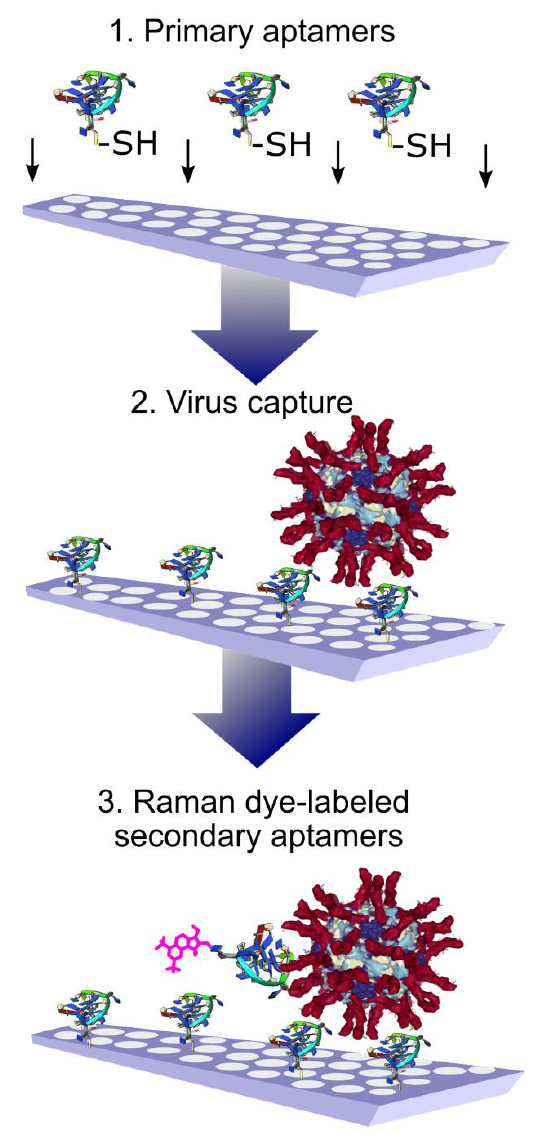
Figure 4. Aptamer-based identification of viral particles on solid substrates. High specificity is achieved due to the presence of a ternary complex with aptamers labeled with Raman-active compounds. Reproduced with permission from [64].